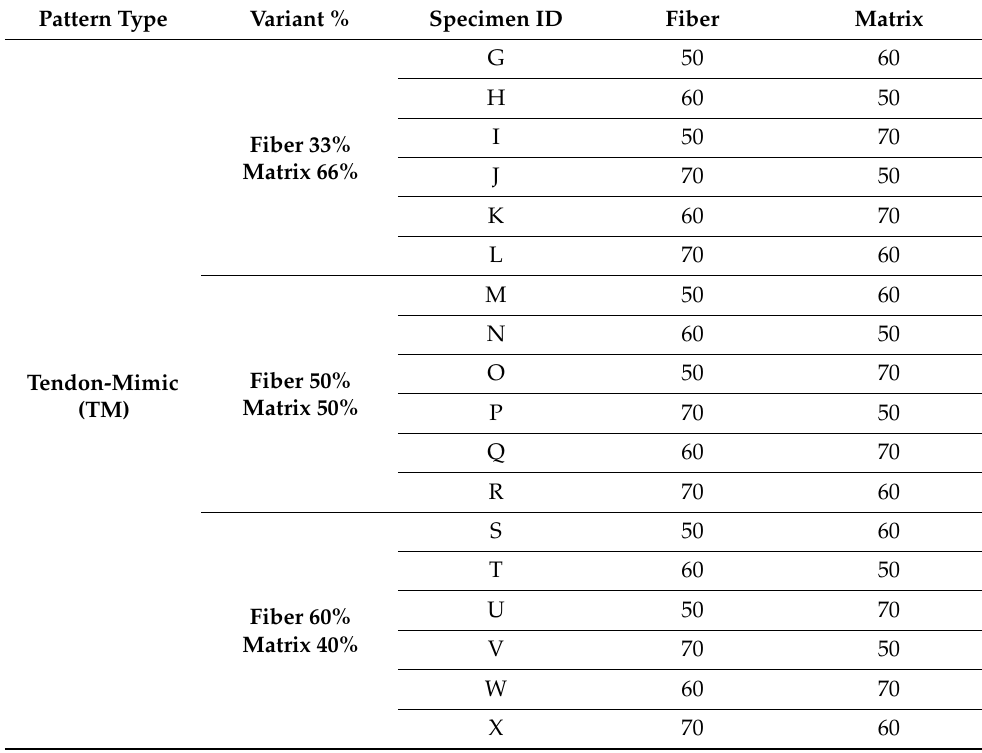
Table 2. Shore A hardness value was assigned for each layer of the Tendon-Mimic (TM) pattern. The range considered was from 50 (medium-soft) to 70 (hard-soft).